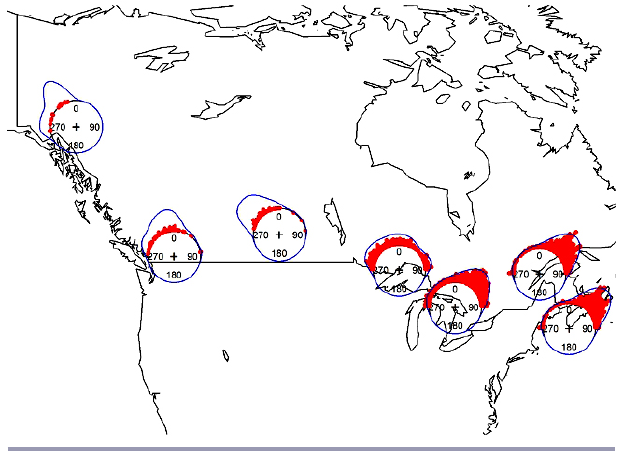
Fig. 4 . Example circular histograms of migration directions calculated from great-circle bearings (°) between banding and recovery locations depicted in Figure 3. Data are as back- bearings used in subsequent analyses. Stacked points represent frequencies, and the blue lines represent kernel density estimates fit to the frequency data using a von Mises’s probability density function (see